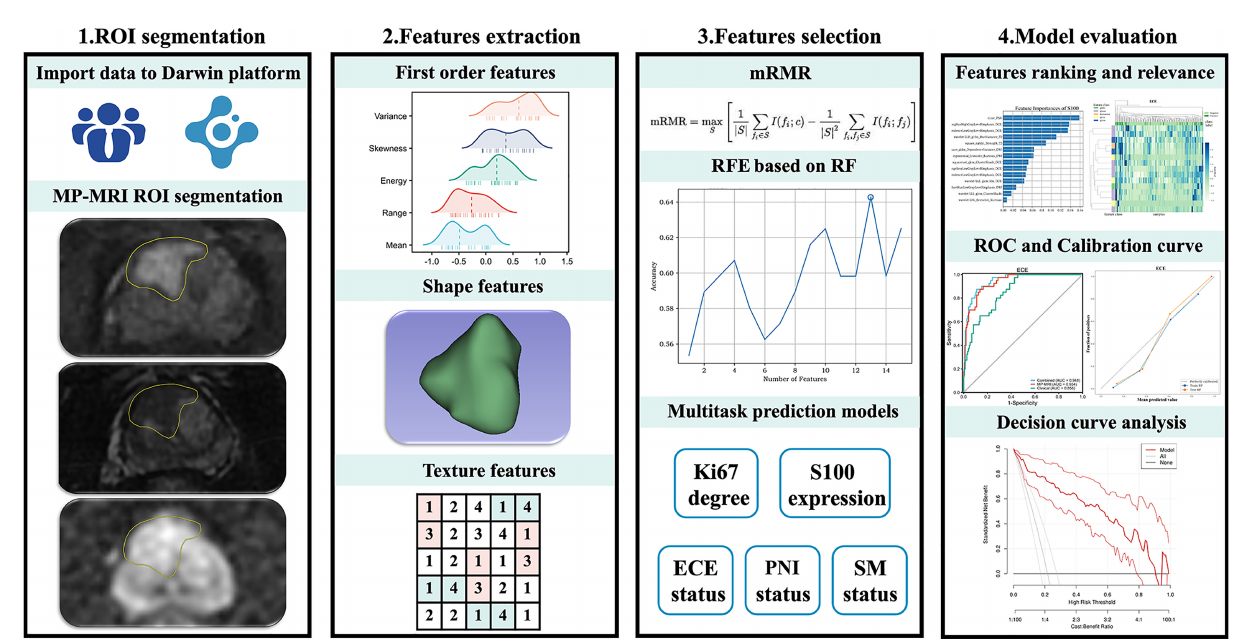
FIGURE 1 | The general work fl ow of this